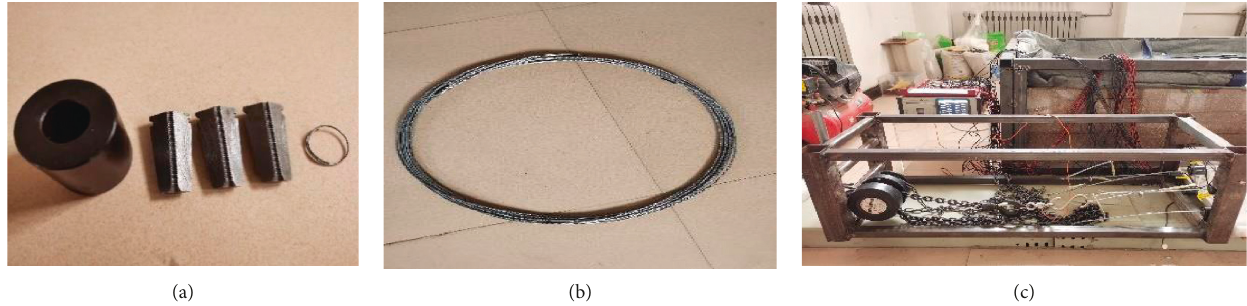
Figure 11: Prestressed loading device: (a) anchor, (b) prestressed steel strand, and (c) prestressed tensioning equipment.